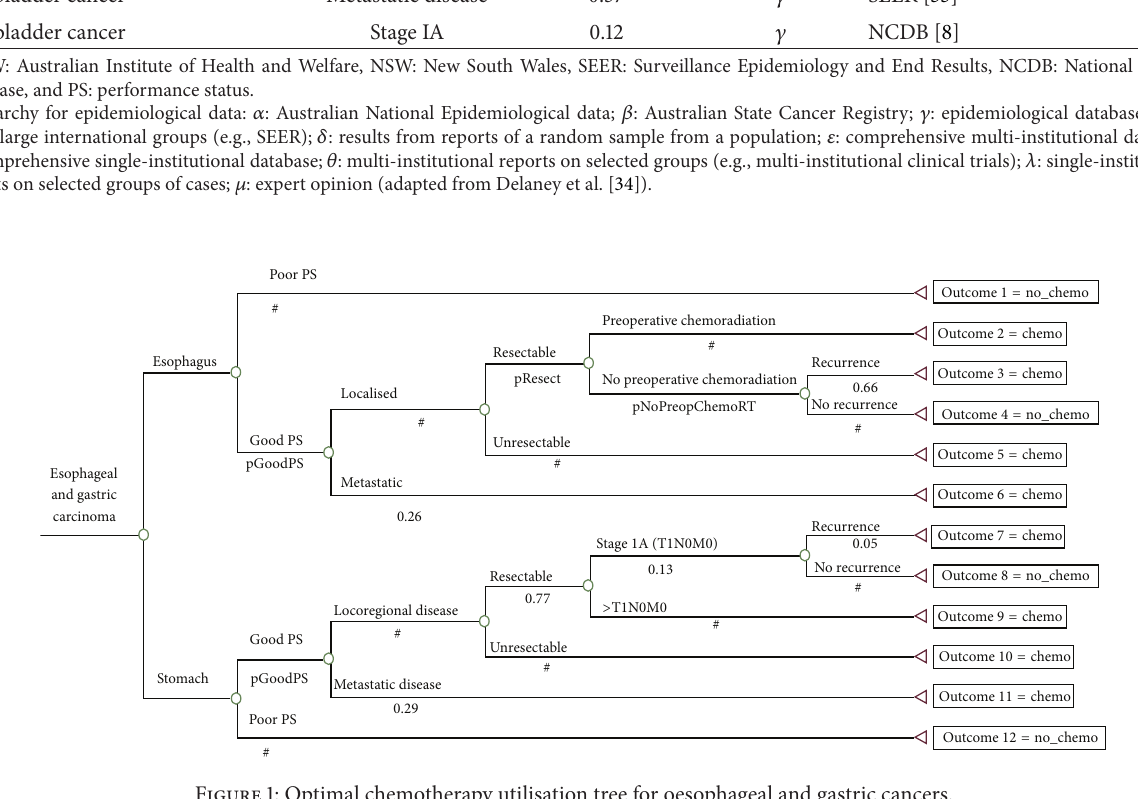
Figure 1: Optimal chemotherapy utilisation tree for oesophageal and gastric